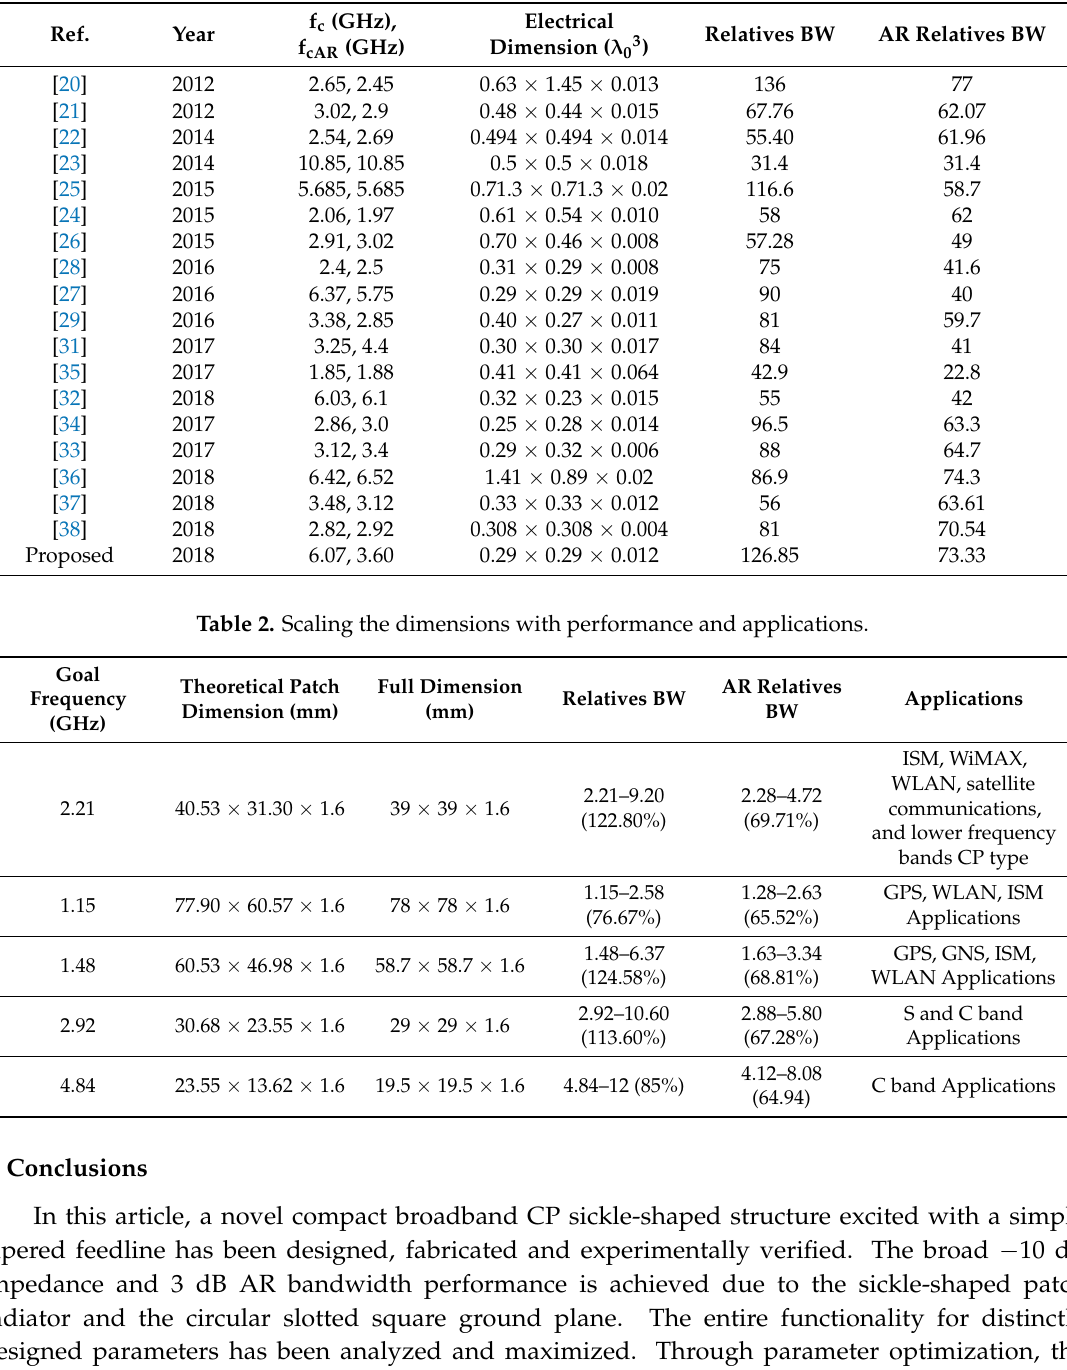
Table 1. Comparison different structures presented in ref.